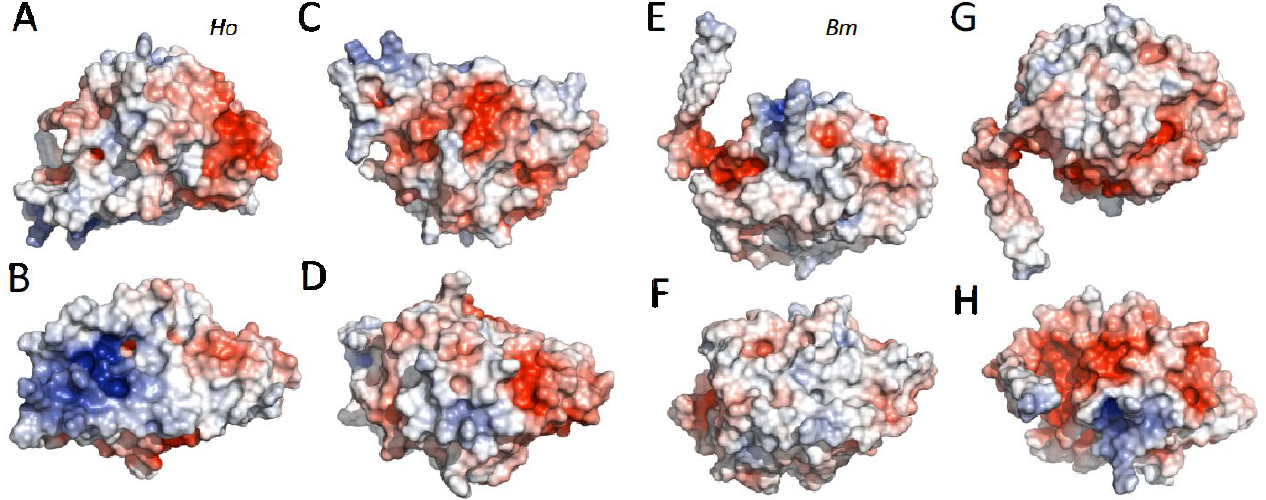
Figure 4. Electrostatic surface potentials. ( A – D ) H . occidentallis ( Ho ). ( E – H ) B. mori ( Bm ). The initial structures ( A , E ) are oriented the same as in Figure 3. Each successive structure has been rotated 90 ° counter-clockwise around the horizontal axis: ( A , E ) front, ( B , F ) bottom, ( C , G ) back, ( D , H ) top. Blue = positive potential. Red = negative potential. See Supplemental Videos SV2 and SV3 for more orientations.